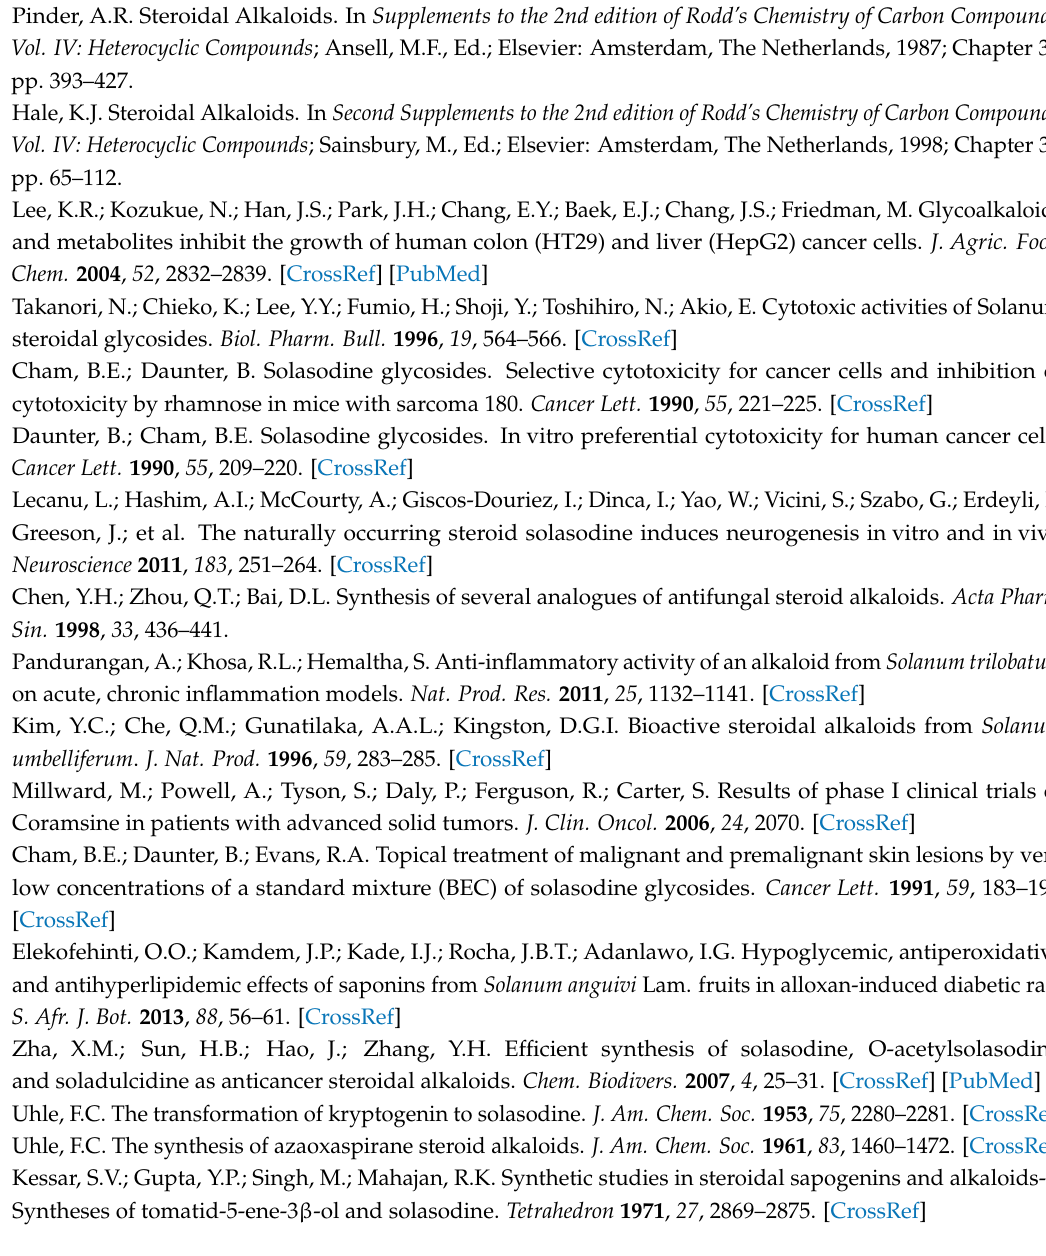
Table S1: A comparison of this synthesis of solasodine with other methods recently described in literature [21–23] and Figures S2–S18: 1 H-NMR, 13 C-NMR, and DEPT spectra of compounds 2 – 5